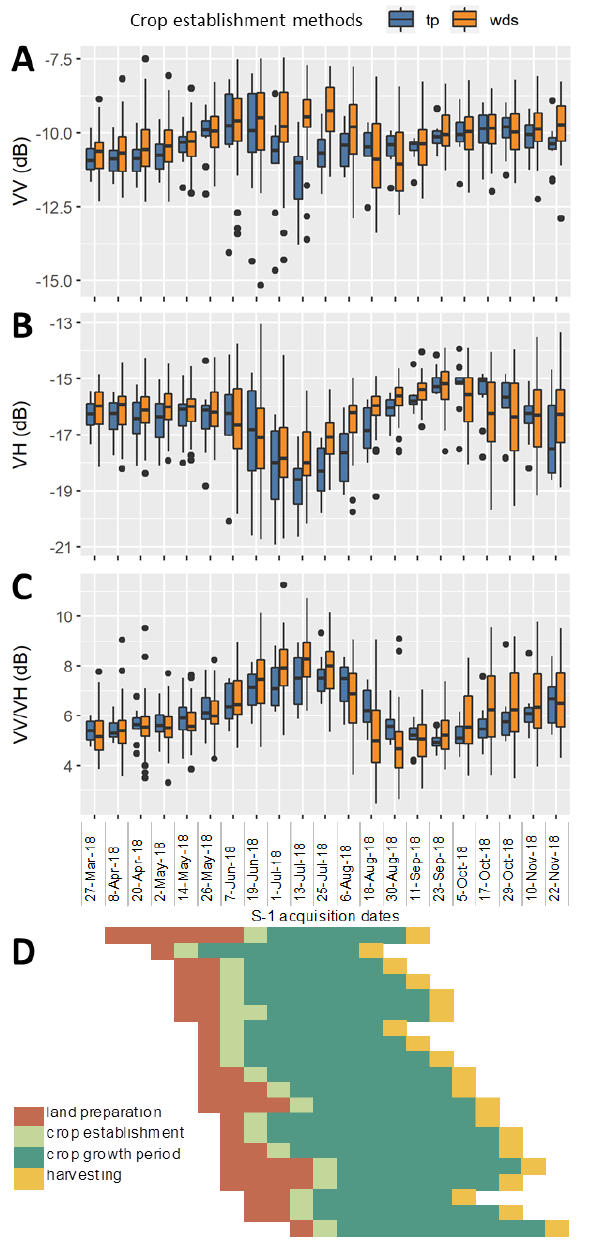
Figure 2. Temporal backscatter signature of transplanted rice (TP) and wet direct rice (WDS) in Iloilo province in the wet season 2018 in (A) VV, (B) VH, and (C) VV/VH ratio ( n : TP=10, WDS=46). Boxplot shows the backscatter extracted for Figure 3. Temporal backscatter signatures in (A) VV, (B) VH, each field and each Sentinel-1 acquisition date. Graph D shows and (C) VV/VH ratio of transplanted rice (TP) and wet direct the corresponding crop calendar in the 2018 wet season based seeded rice (WDS) in 186 fields from the four provinces in the on farmer interviews in Iloilo. wet season 2018. Boxplot shows the backscatter values (in dB) for land preparation (LP), one acquisition before crop establishment (CEb1), crop establishment (CE), one acquisition after CE (CEa1), two acquisitions after CE (CEa2), tillering- stem elongation (TL_SE), heading-flowering (HE_FLW), maturity (MT), and harvesting